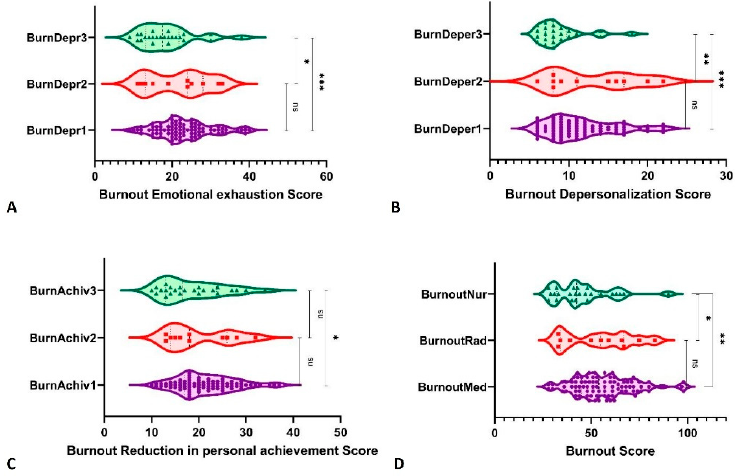
Figure 1. Burnout comparisons between the groups of participants (1 = medical oncology, 2 = radiation oncology, 3 = nurses). *, p -value < 0.05; **, p -value < 0.01; ***, p -value < 0.001; ns, not significant. The mean total QoL was 0.93 (SD = 0.06, range = 0.72–1.00) according to the mean directions for sleeping: 0.81 (SD = 0.2, range = 0.30–1), speech: 0.88 (SD = 0.16, range = 0.43– 1), mental: 0.89 (SD = 0.17, range = 0.38–1), depression: 0.82 (SD = 0.18, range = 0.31–1), distress: 0.71 (SD = 0.21, range = 0.13–1), vitality: 0.77 (SD = 0.19, range = 0.13–1), and sexual activity: 0.83 (SD = 0.23, range = 0.13–1). The QoL score comparisons between the groups of participants are shown in Figure 2.